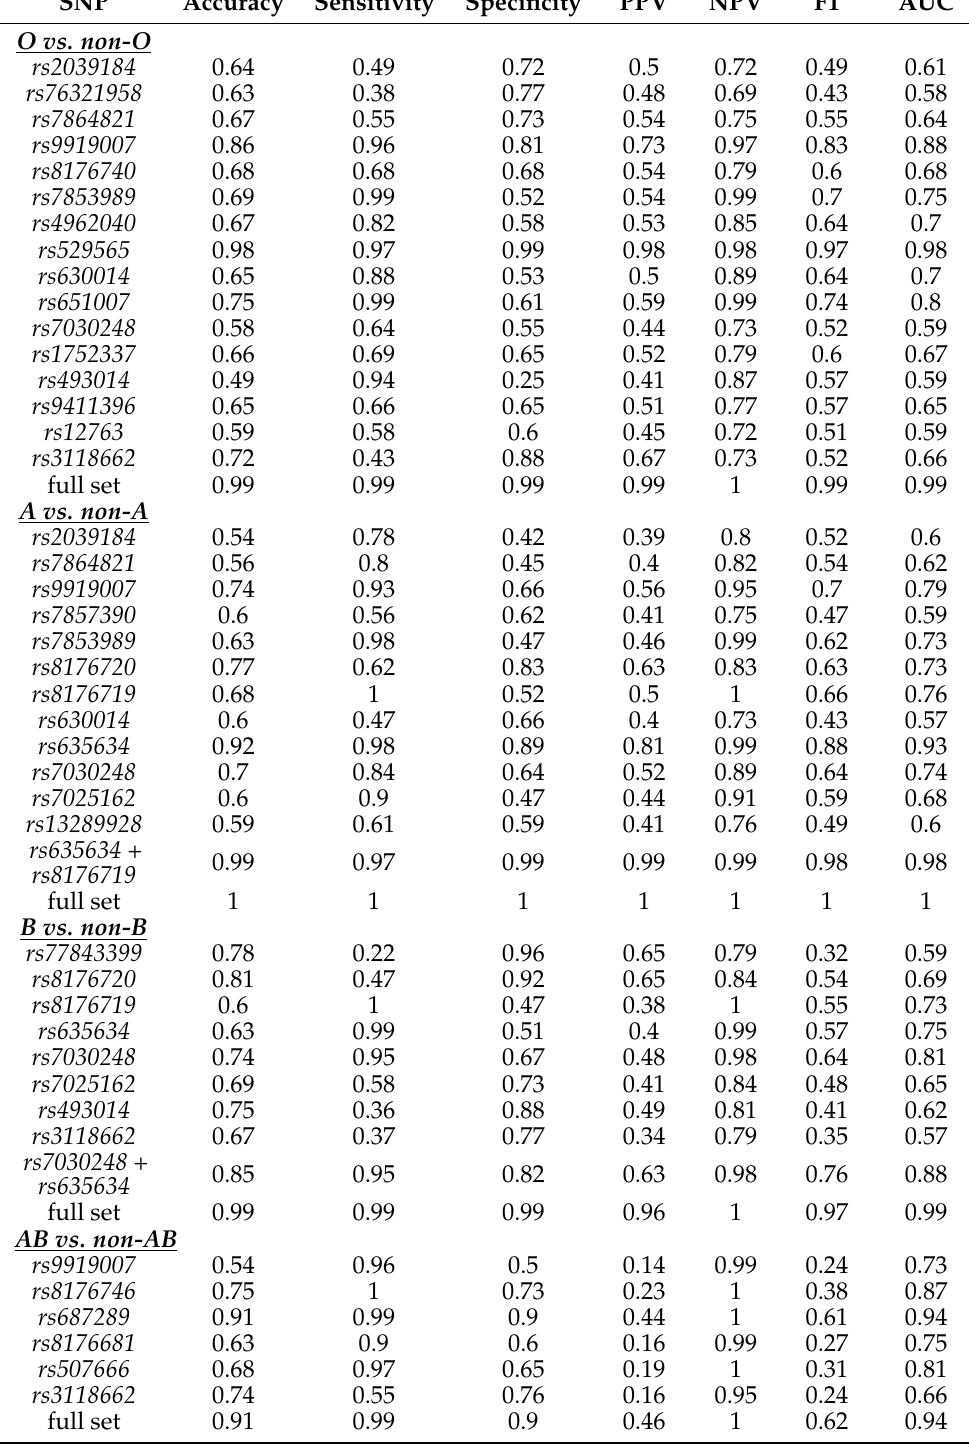
Table 1. Classification performance of selected SNPs in GWAS for binary ABO blood